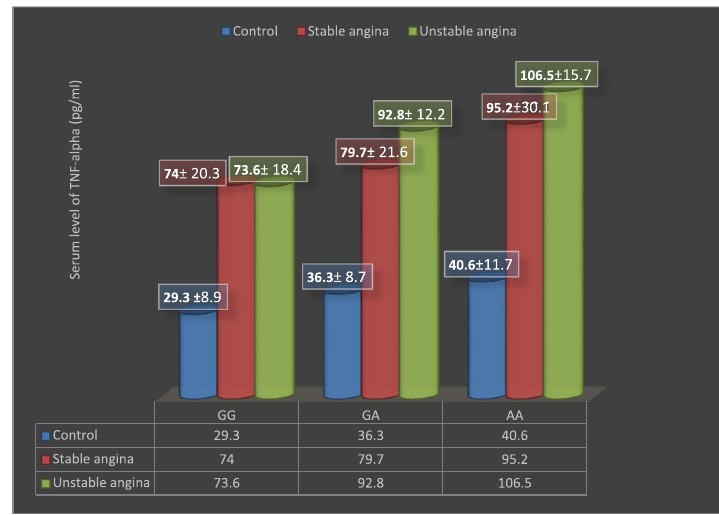
Fig. 1 Serum level of TNF-alpha (pg/ml) pattern in control, stable angina, and unstable angina according to the (rs1800629)-308 G/A SNP proportions